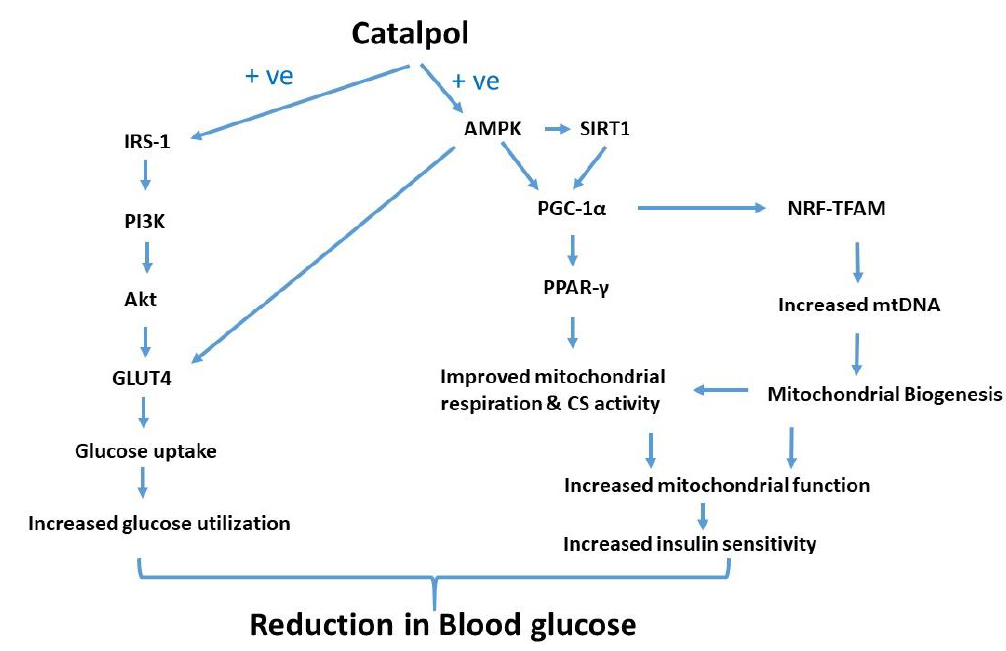
Figure 7. Putative molecular pathway of catalpol in the skeletal muscle of type-2 diabetic mice in amelioration of glucose homeostasis and insulin sensitivity.